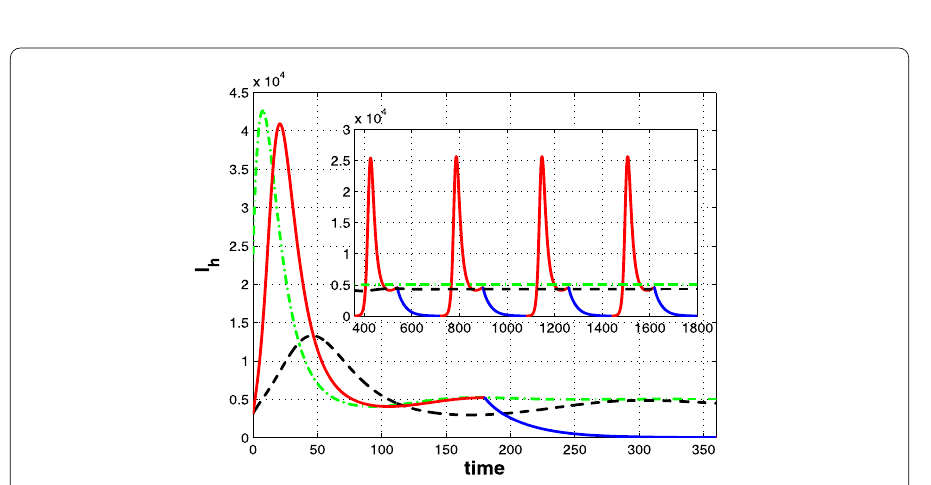
Figure 3 The effect of seasonal succession on the persistence of mosquito-borne disease